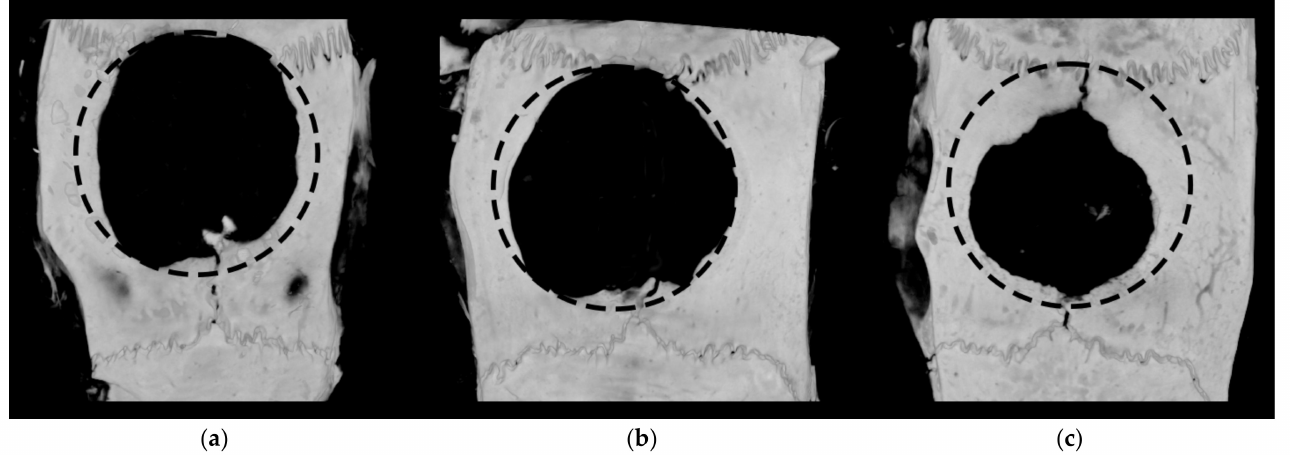
Figure 6. Representative 3D reconstruction images at 8 weeks after SA scaffold implantation into a critical-sized cranial defect. New bone formation in the defects treated with ( a ) scaffold only; ( b ) GAS with pEGFP/PEI; and ( c ) GAS with pBMP-2/PEI. Micro-CT. Dashed line—initial defect zone with a diameter of 7.5 mm.